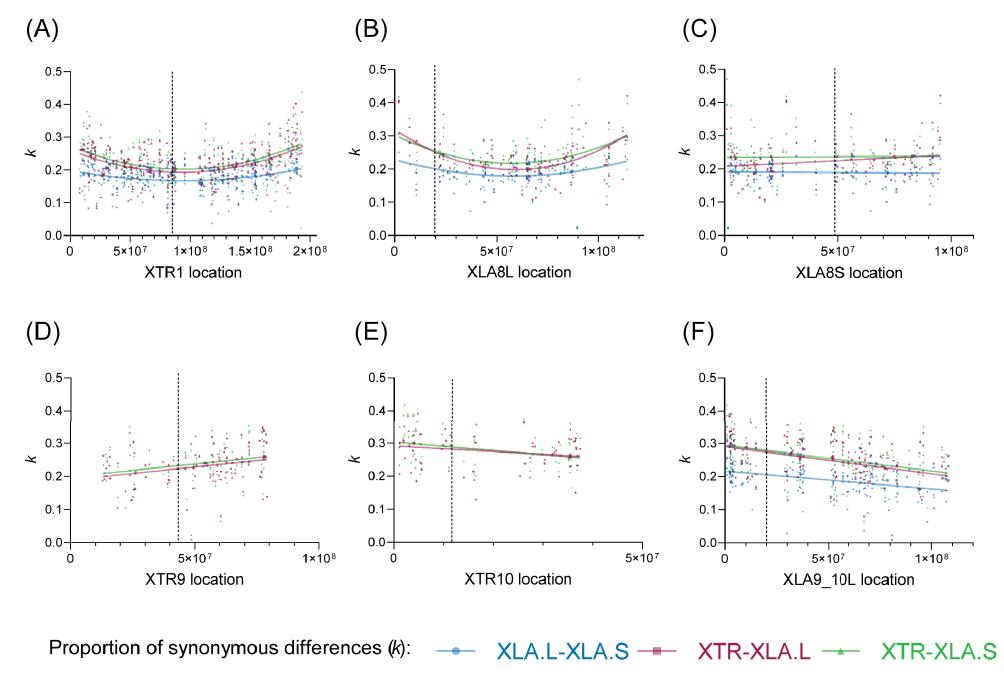
Fig 2. Relationship patterns between proportion of synonymous substitutions ( k ) and chromosome location. Representative figures displaying different relationship patterns for each genome pair combination (XTR-XLA.L in red, XTR-XLA.S in green, and XLA.L-XLA.S in blue). (A) Chromosome 1 (e.g. XTR1) showed a common non-linear relationship between k and location. This higher k in distal parts of the chromosome was also seen in chromosomes 2 to 7, irrespective of the genome used for location in the x-axis (S1 Fig). (B, C) Chromosome 8 showed contrasting patterns based on the genome used for location reference: (B) XTR8 (S1 Fig) and XLA8L showed higher k in the distal part of chromosome, while (C) XLA8S had no marked relationship between k and location, likely due to intra-chromosomal rearrangements [6]. (D) In XTR9, k increased distally with location, while (E) it decreased in XTR10; (F) in the homoeologous XLA9_10, k decreased with location. Centromere positions are indicated by dotted vertical line and estimated based on position of frog centromeric repeat 1 (Fcr1) [21] or centromeric markers from X . tropicalis [22]. Full results are shown in S1 Fig.